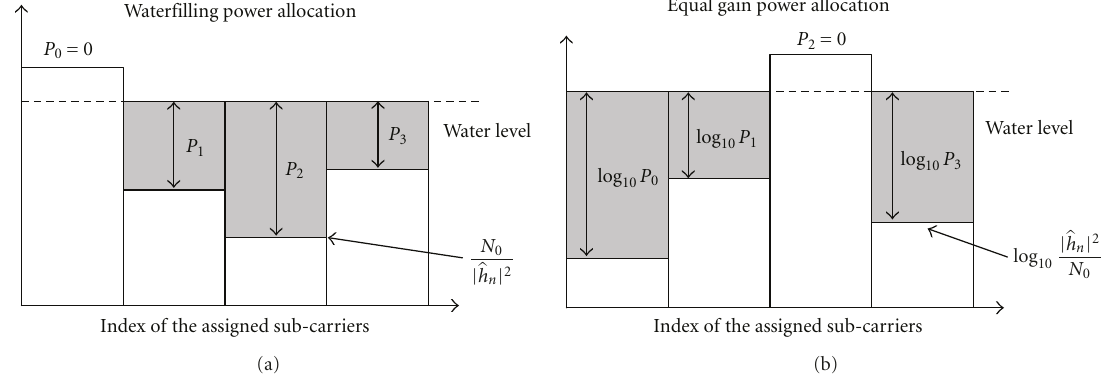
Figure 3: Comparison of geometrical interpretation between the waterfilling power allocation (a) and equal gain power allocation (b).